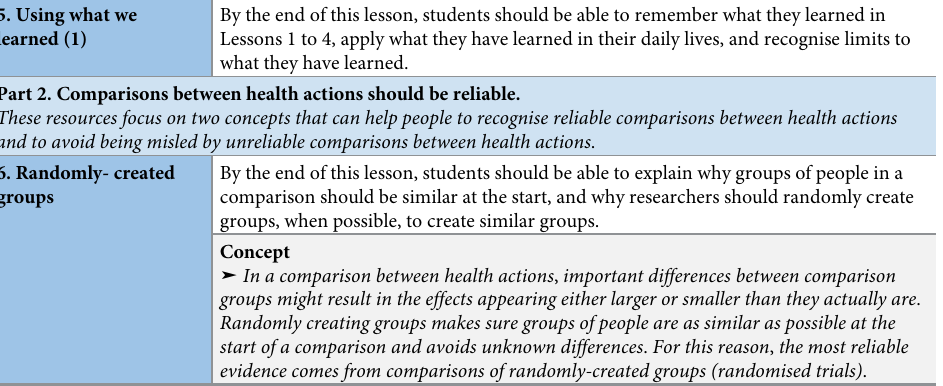
Learning goals and